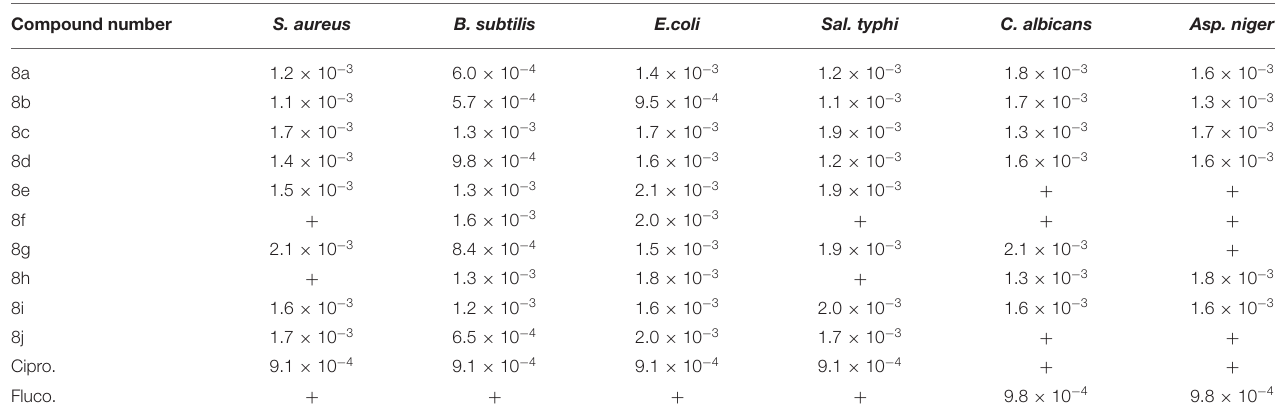
TABLE 4 | Minimum inhibitory concentration (MIC) in molar concentration. Compound